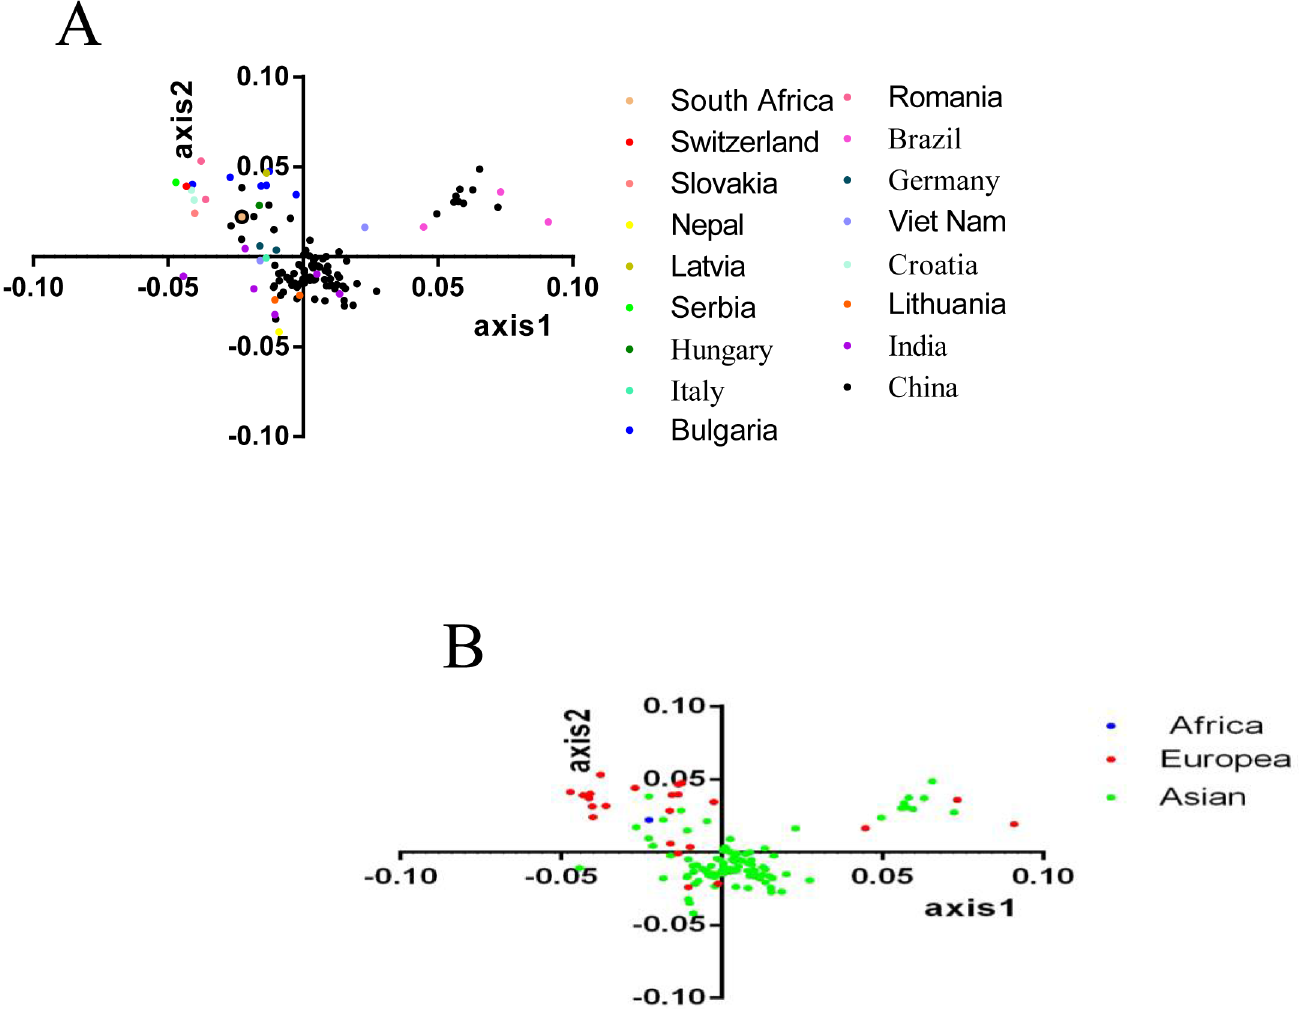
Fig 3. PCA analysis, 1st axis plotted against 2nd axis according to the geographical distribution (A) isolatedcountries; (B) isolatedcontinents. Different geographicaldistributions are representedby different colors. https://doi.org/10.1371/journal.pone.0183646.g003 Table 2. The correlation analysis of nucleotide composition, Axis1, Axis2, Gravy, Aroma, nucleotide at the third position and ENC. A C G